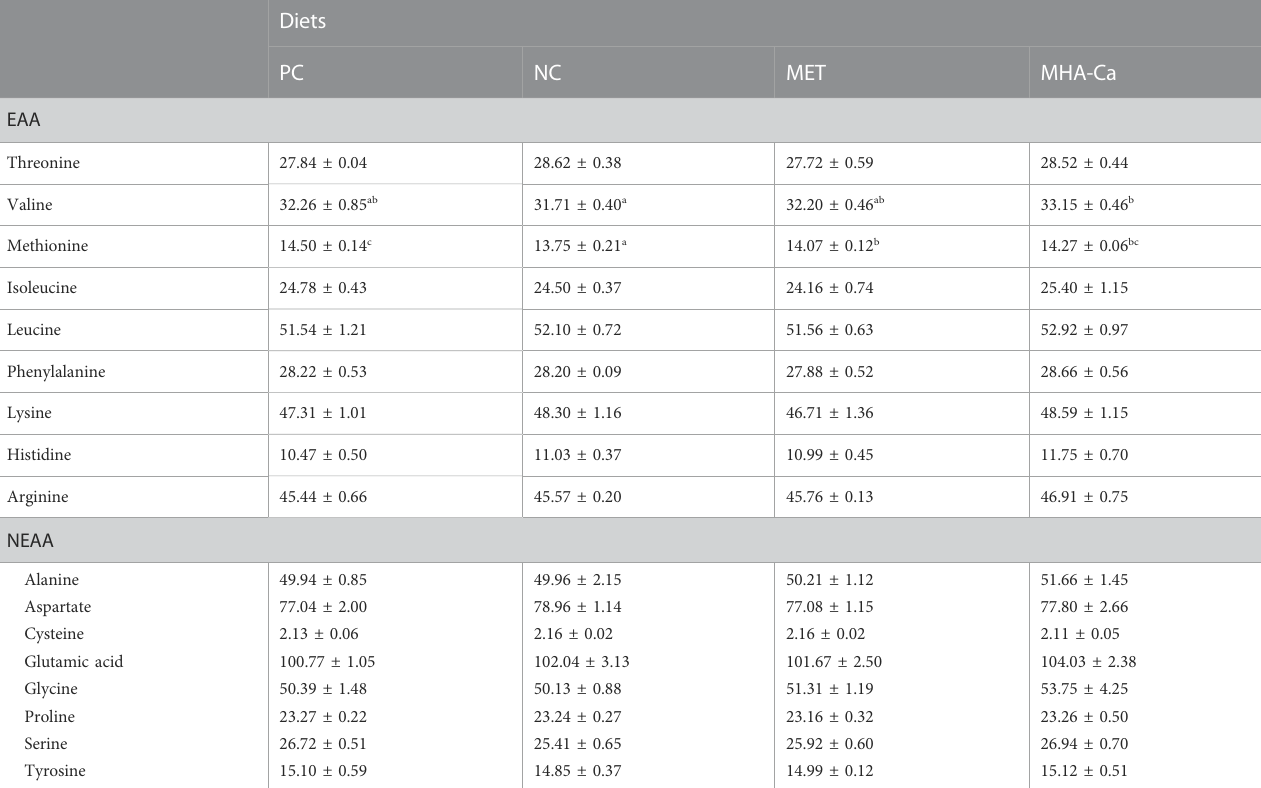
TABLE 6 The amino acid composition in the whole body of L. vannamei fed the experimental diets (g/kg dry matter).